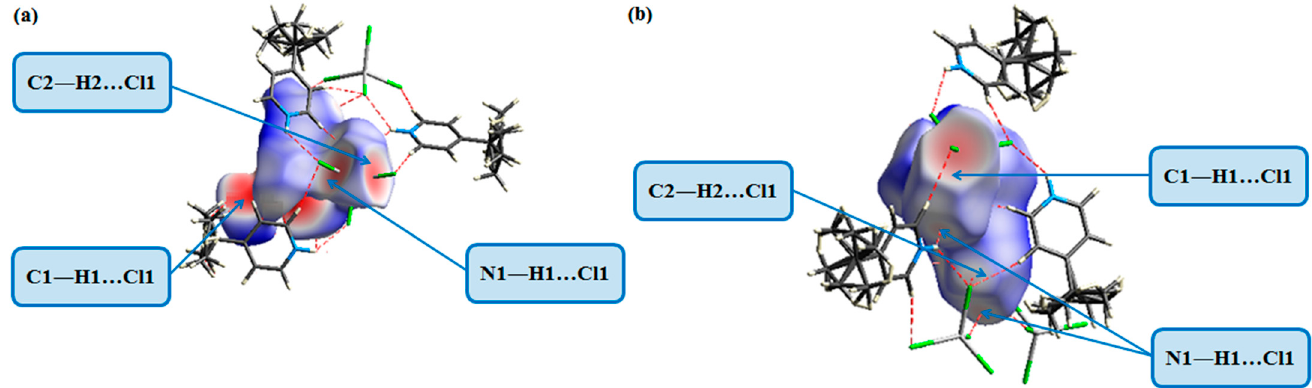
Figure 6. H-bonds present in compound [C 9 H 14 N] 2 [MnCl 4 ] ( a ) and in compound [C 9 H 14 N] 2 [CoCl 4 ] Figure ( b ).